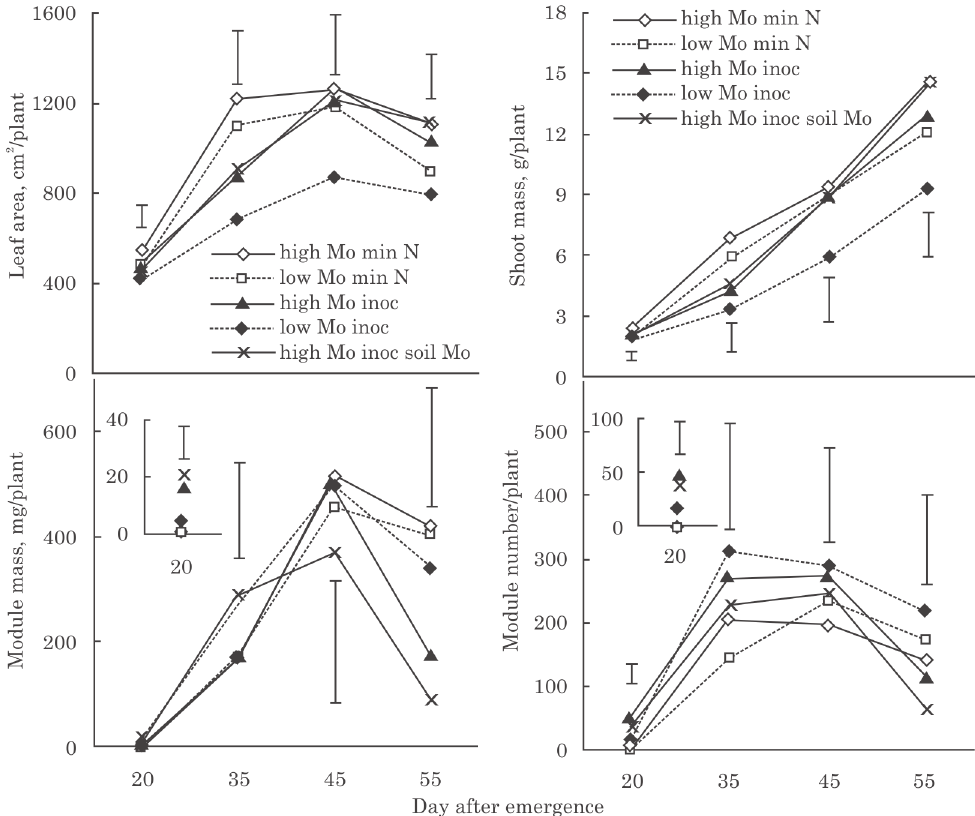
Figure 1. Leaf area, shoot dry mass, nodule dry mass and nodule number of common bean plants originating from seeds with low or high Mo concentration grown at two N sources (inoculated with rhizobia or mineral N) or with additional Mo applied to the soil, at four growth stages (Experiment 1); insets display values of 20 DAE. Vertical bars represent the least significant difference by Tukey’s test at 0.05 probability and compare treatments on each evaluation